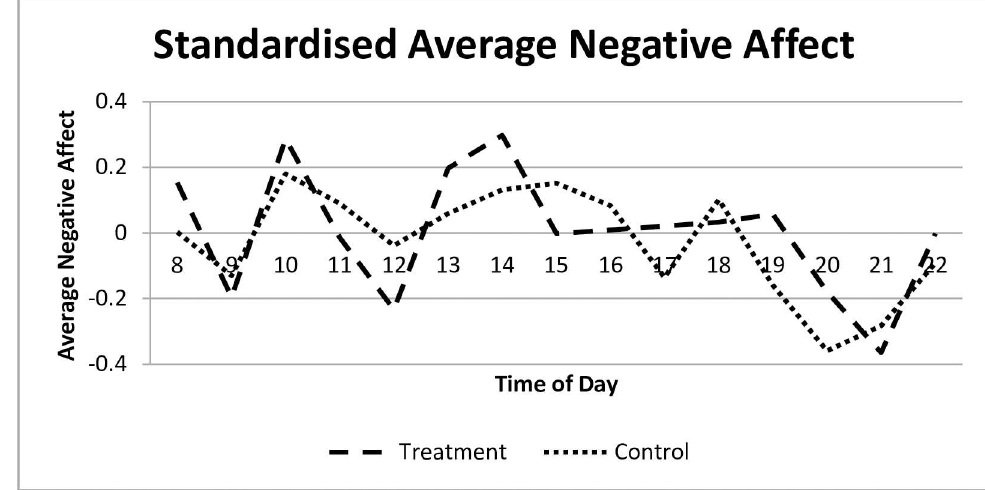
Fig 3. Standardized averagenegative affect for treatment and control